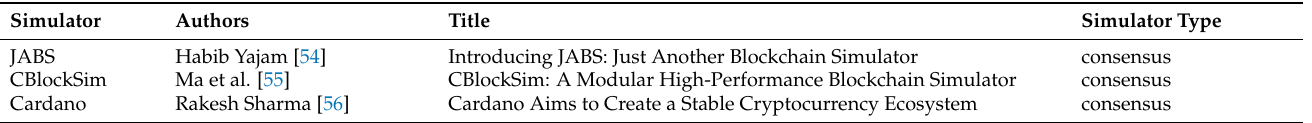
Table 4. Potential blockchain simulators for IoT environments.